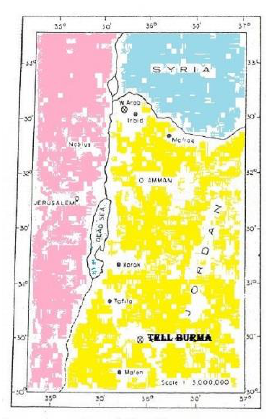
Figure 2: Geographic location of the Tell Burma section (South Jordan) and Wadi Arab section, North Jordan (Futyan, 1976).